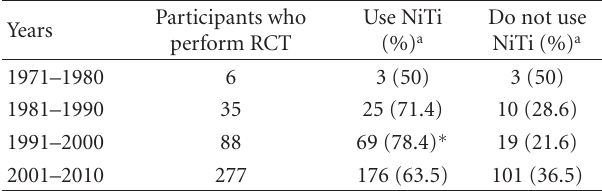
Table 3: Response details for NTRF and year of